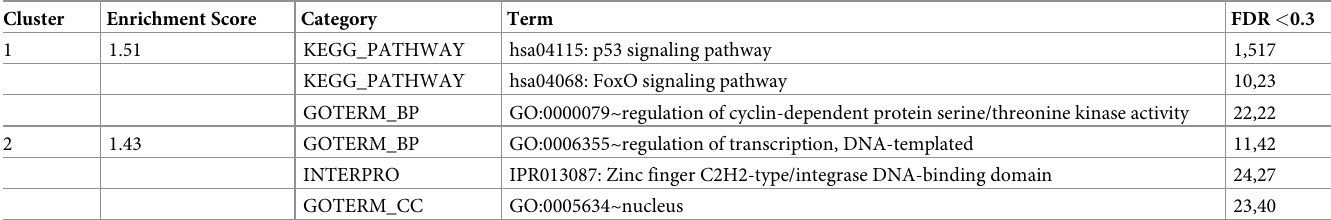
Table 3. DAVID functional annotation clustering of down-regulated genes in cEDS patients’ skin fibroblasts.